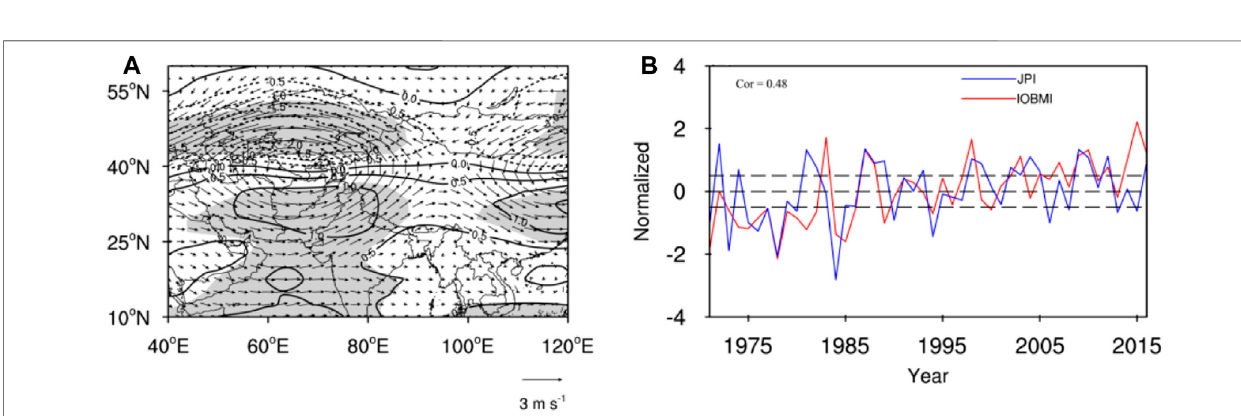
Frontiers in Earth Science |